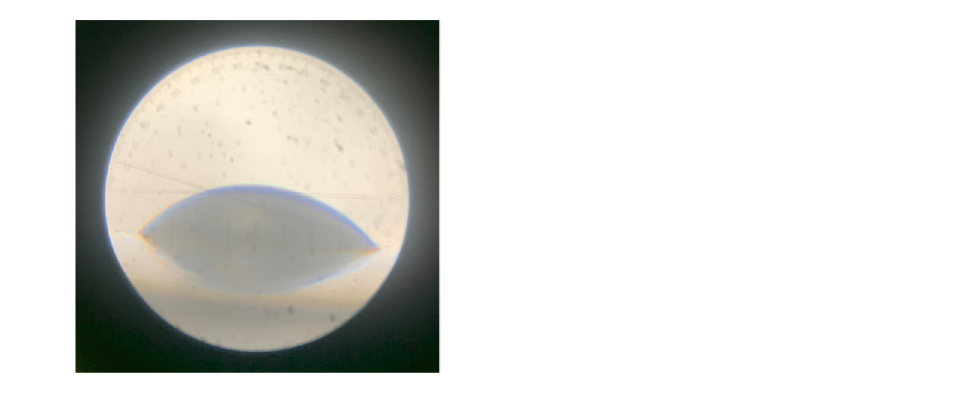
Figure 7. Actual image water droplet on the amie-modified surface at contact measurement.